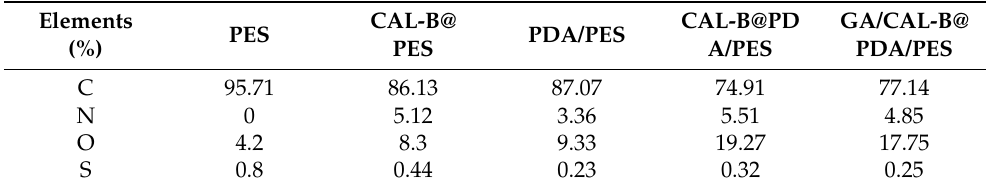
Table 1. Elements analysis on the new membrane, CAL-B@PES, PDA/PES, CALB@PDA/PES and